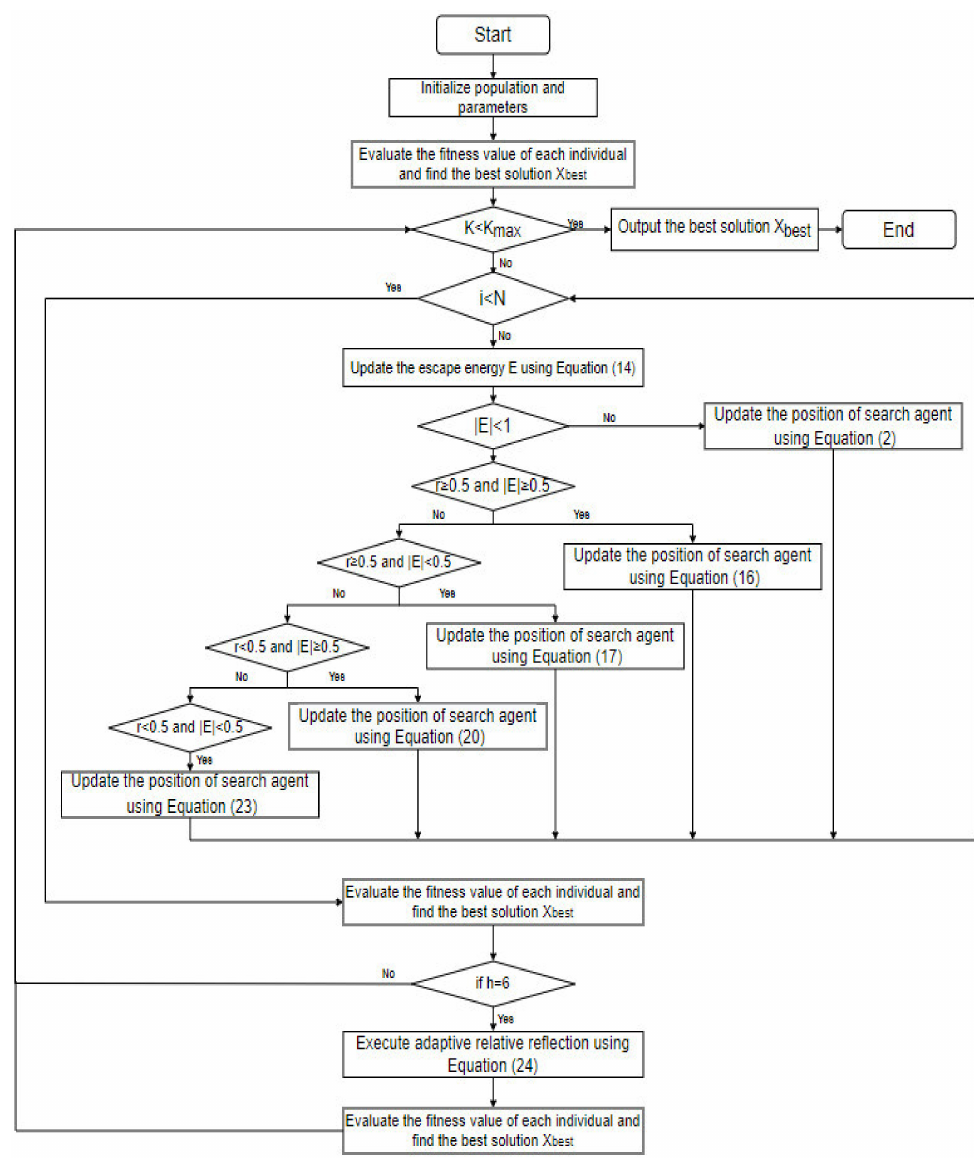
Figure 5. Flowchart of